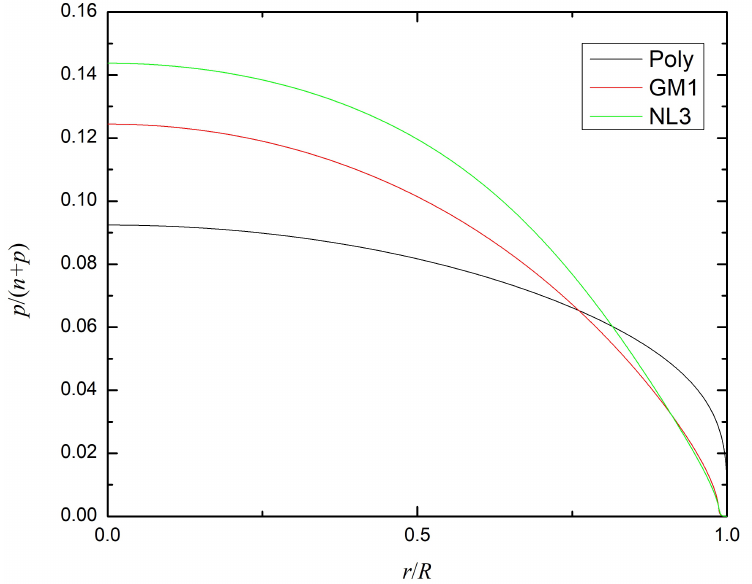
Figure 1. Profiles of the proton fraction p / ( n + p ) for 1.4 M (cid:12) neutron stars constructed from the polytropic (Poly), GM1, and NL3 EOS